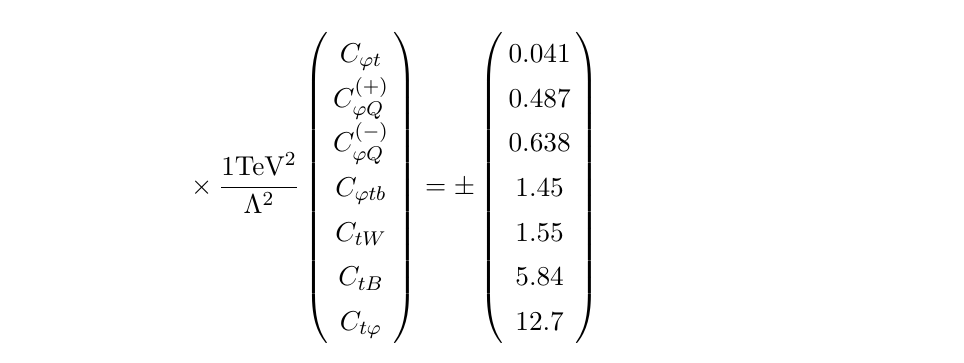
Figure 3 . Sensitivities for each eigenstates, and the relative contributions from each channel for (cid:22) EFT = 1000